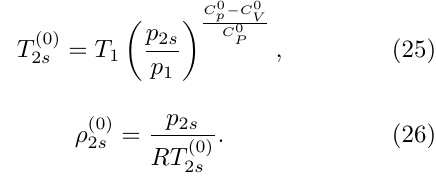
Table 1. Combination of output and input parame- ters for isentropic process.